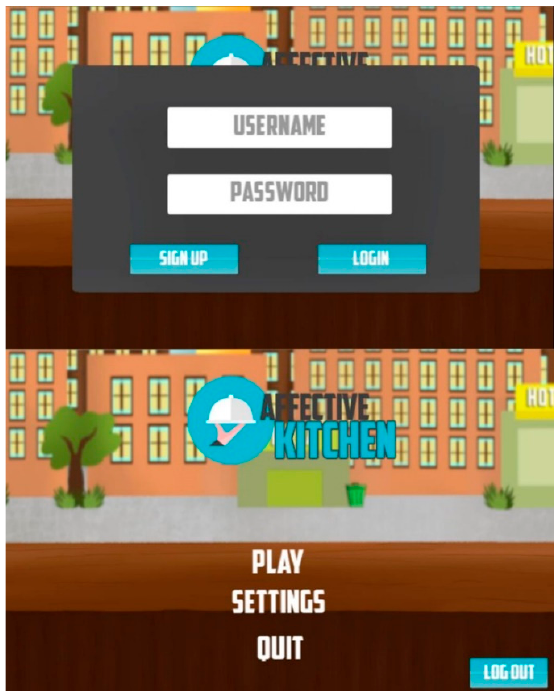
Figure 5. Login and Main Menu screen.